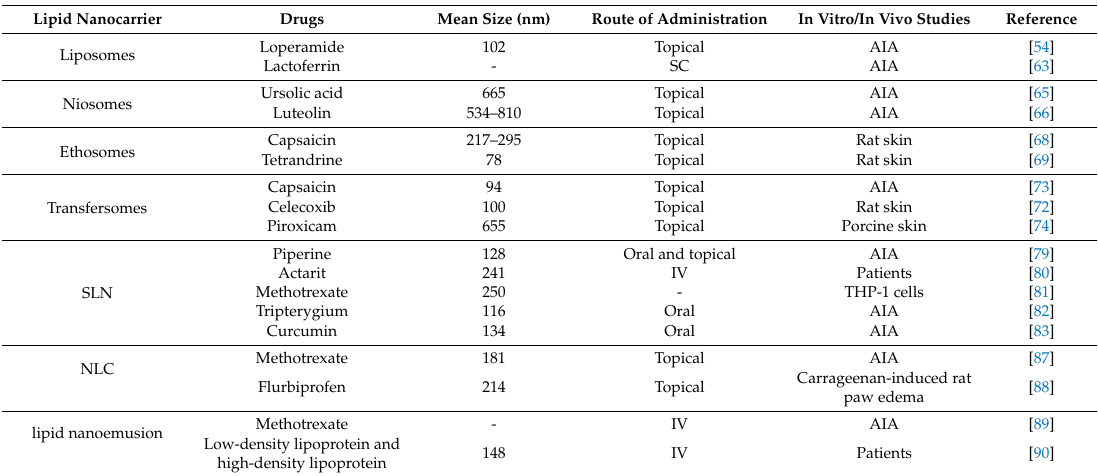
Table 3. Application of lipid-based nanoparticles for rheumatoid arthritis.